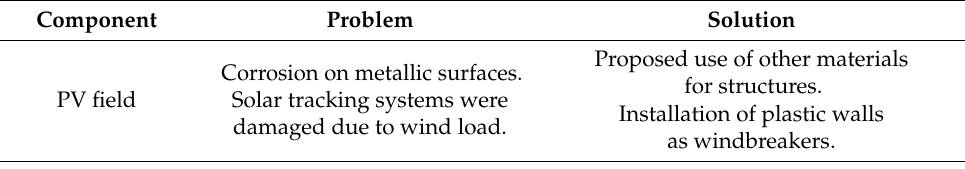
Table 9. Main operational problems after installing and running PV-powered RO